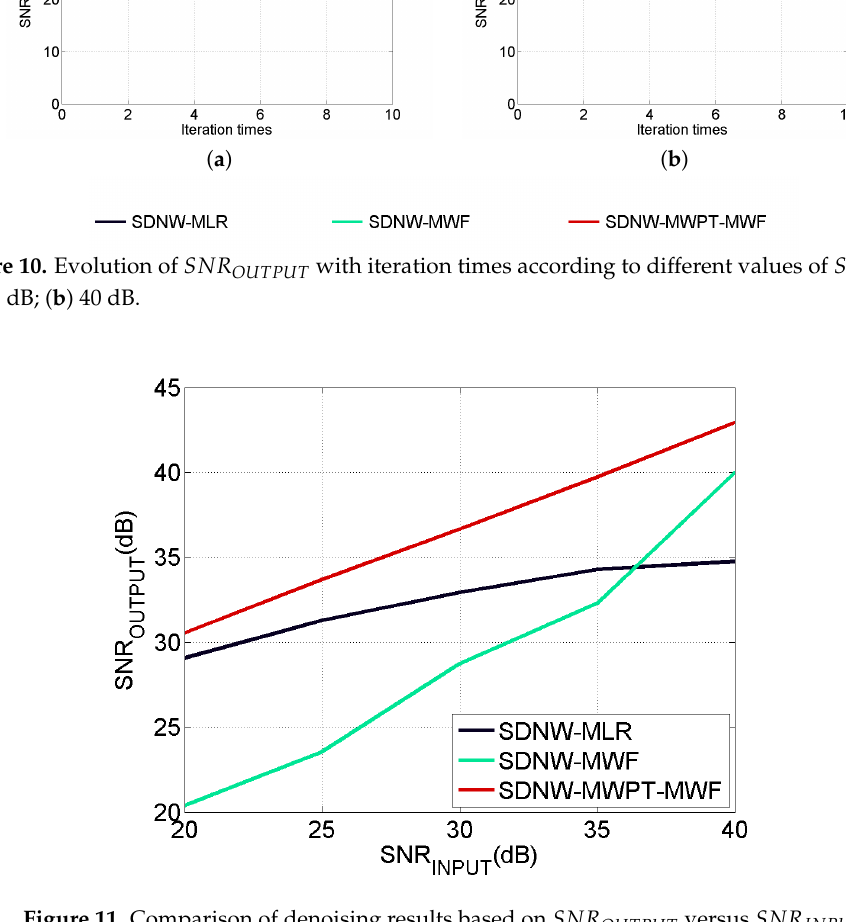
Table 1. The SVM classifier is employed to do the classification and its kernel function is RBF with γ = 1 and the penalty parameter C =